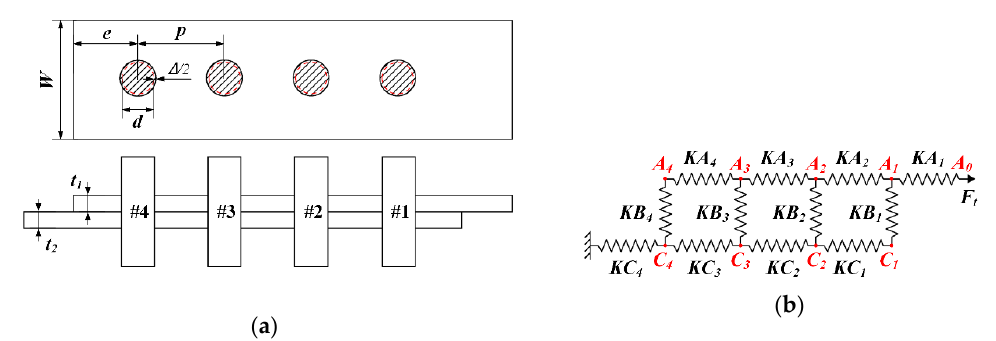
Figure 4. Spring-mass model of the riveted lap joint with four rivets: ( a ) Simplified model, where 𝑊 represents the plate width, 𝑒 represents the rivet margin, 𝑝 represents the rivet pitch, 𝑑 is the rivet diameter, 𝛥 represents the interference, 𝑡 1 and 𝑡 2 represent the thicknesses of the upper and lower plates, respectively; ( b ) spring-mass model, where 𝐾𝐴 𝑖 represents the spring stiffness of the upper plate, 𝐾𝐵 𝑖 represents the spring stiffness of rivet and 𝐾𝐶 𝑖 represents the spring sti ff ness of the lower plate.